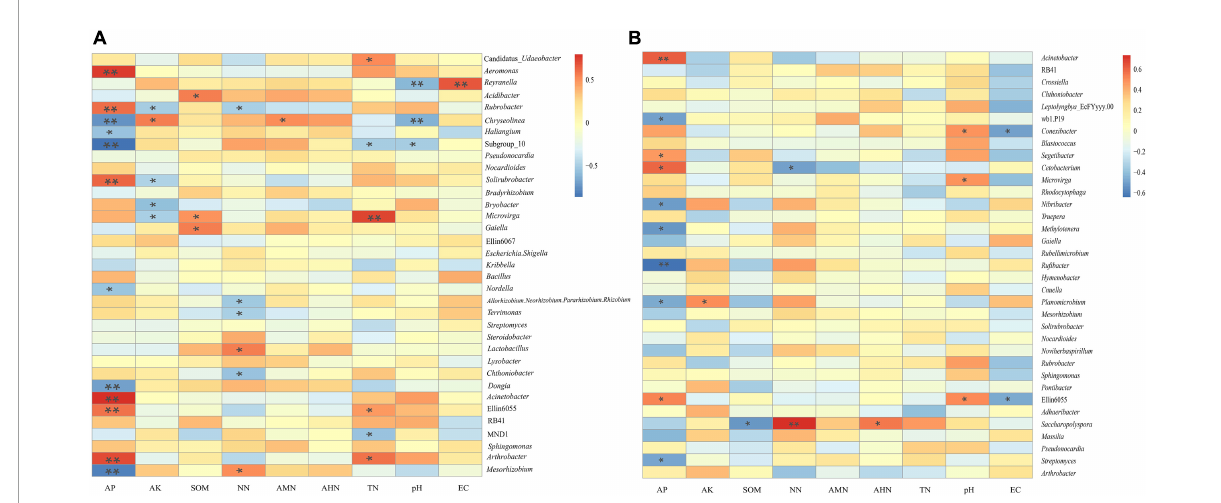
FIGURE8 Heatmap of the correlation between the soil’s physicochemical properties and the genus-level bacteria. (A) is the correlation between physicochemical properties of rhizosphere soils and the genus-level bacteria. (B) is the correlation between physicochemical properties of bulk soils and the genus-level bacteria. * and ** indicate P < 0.05 and P < 0.01, respectively.